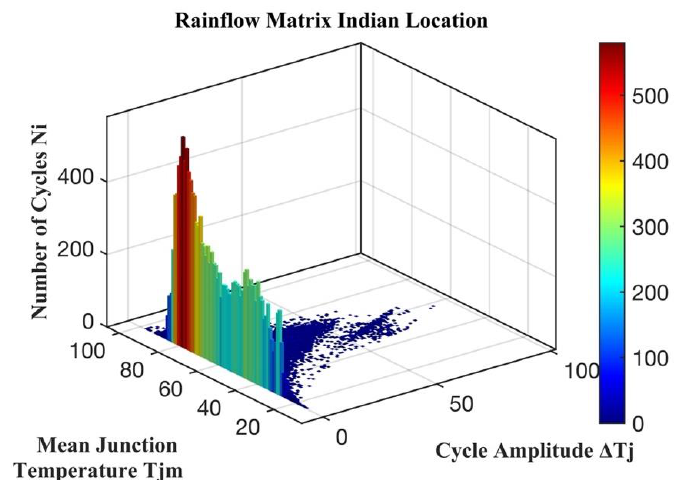
Figure 9. Rainflow matrix at the location in India.